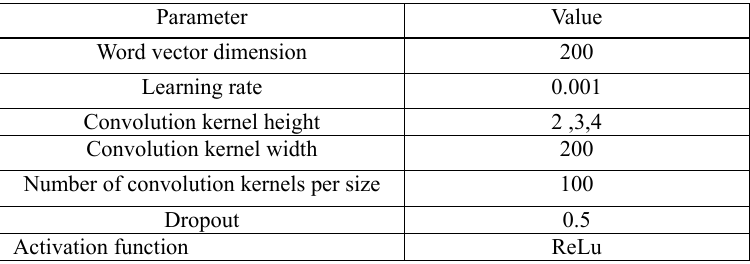
Table 2. CNN network parameters.